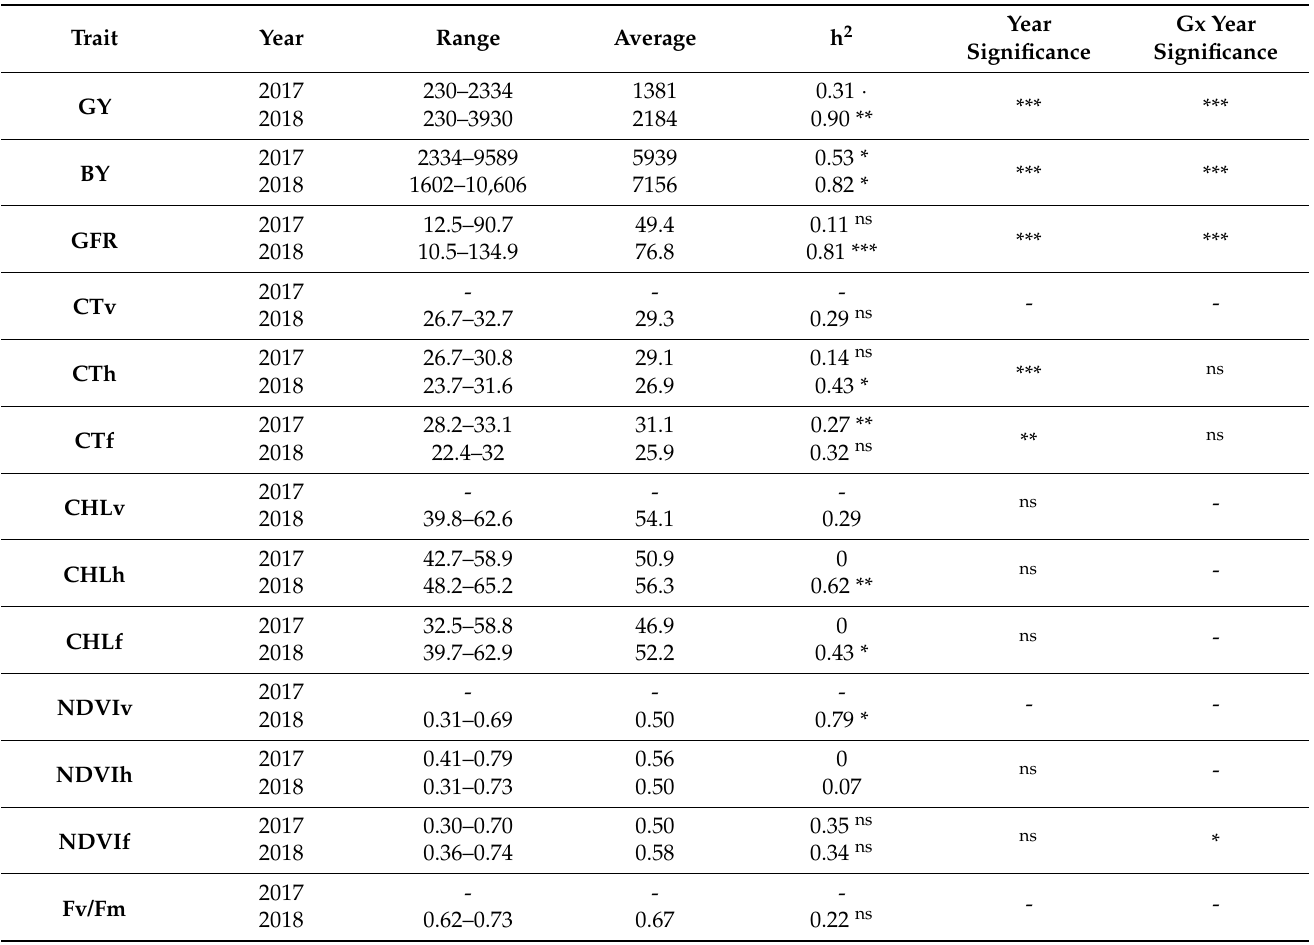
Table 7. Heritability and significance of genotypes, year, and their interaction on agronomic and physiological traits collected under continuous heat stress at wad Medani during two seasons: 2016–2017 and 2017–2018.